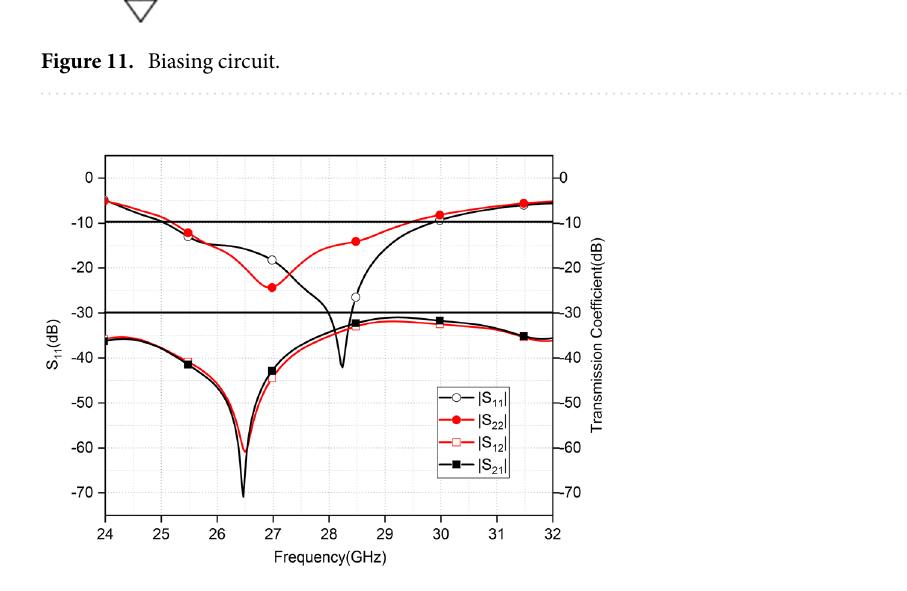
Figure 12. Reflection coefficient and transmission coefficient of